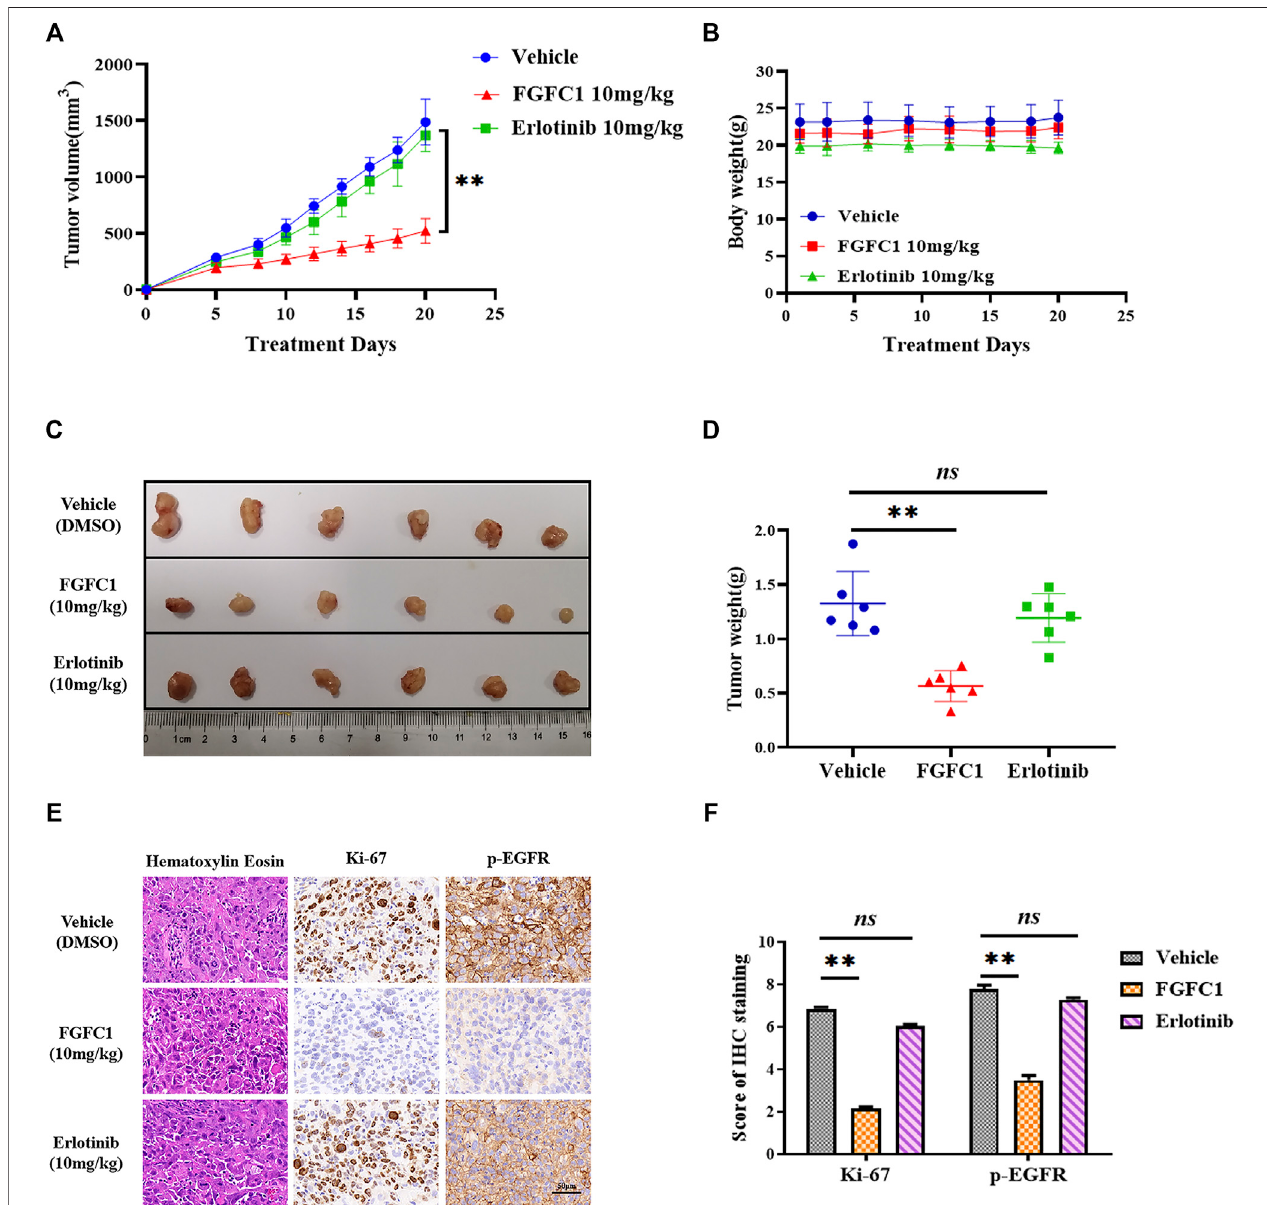
FIGURE 6 | FGFC1inhibited the growth of H1975 cell-derived tumor in vivo . H1975 cells were subcutaneously inoculated into the fl ank of nude mice. The mice were randomizedintothreegroups. (A) Tumorvolumewasmeasuredbycaliperonceevery3 dayswhenthetumorreachedapproximately60 mm 3 insize. (B) 7 daysafterH1975 cells implantation, mice were treated with vehicle (5% DMSO in PBS, ip), FGFC1 (10 mg/kg, ip) and erlotinib (10 mg/kg, ip) once a day for 21 consecutive days. The body weightwasquanti fi edineachgroup. (C) Therepresentativestrippedimagesofthetumorentityafterbeingtreatedwithvehicle,FGFC1anderlotinibfor21 days. (D) The scatterplotsummarizedtheweightofthetumors. (E) FGFC1decreasedtheexpressionofp-EGFR,Ki-67 invivo .Theexpressionofp-EGFRandKi-67intumortissuesfrom nude mice was assessed by immunohistochemistry (400 × ) (scale bar (cid:1) 50 μ m). (F) The IHC score of p-EGFR and Ki-67 was quanti fi ed by the IRS system ( n (cid:1) 10 fi elds of view). All data were represented as the means ± SD for at least three independent experiments. ( *p < 0.05 and **p < 0.01 vs the DMSO